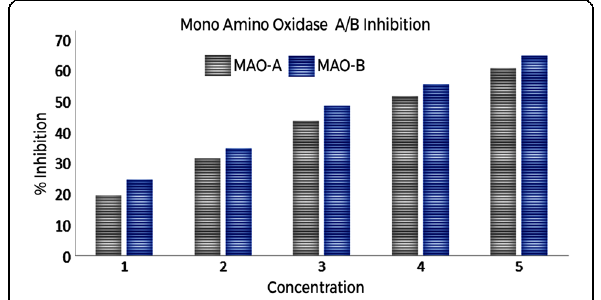
Fig. 9 Monoamine oxidase inhibition